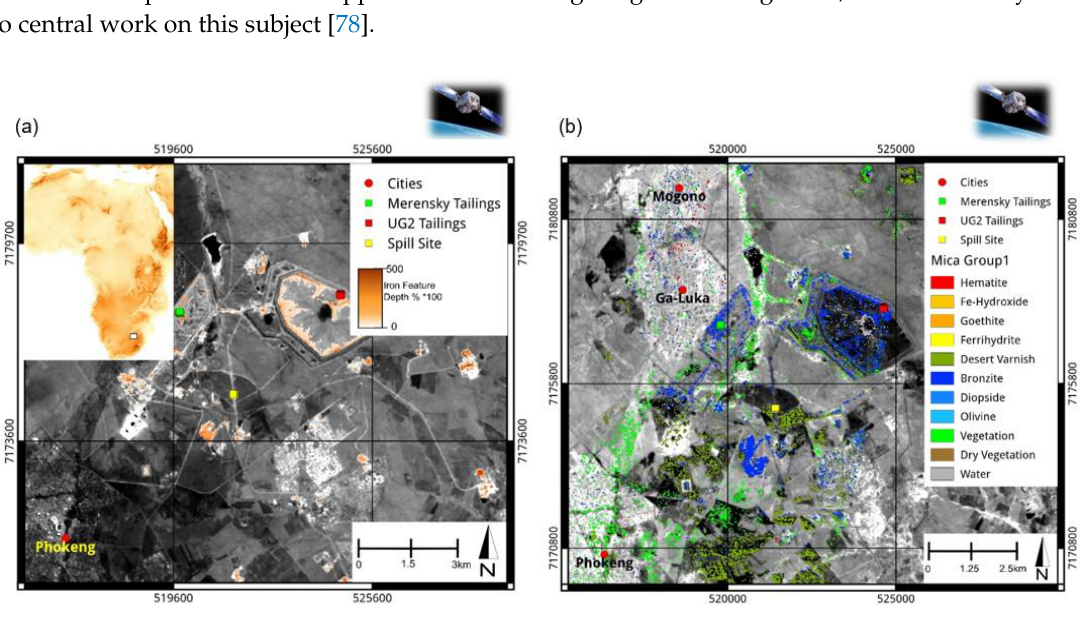
Figure 4. Geological classification: ( a ) Expert system result showing mineral and material abundance in the Platinum mining area near Rustenburg (USGS MICA) from EO-1 Hyperion data; expert system result overlaid with Landsat-8 OLI near-infrared channel. ( b ) Iron feature depth result calculated from Landsat-8 OLI data in the Platinum mining area near Rustenburg (USGS MICA). Expert system result overlaid with Landsat-8 OLI short-wave infrared channel. Inset map of the topography of Africa from ETOPO-1 data (data provided with the courtesy of NOAA). White rectangle outlines the areas that are most affected by mining activity in South Africa. (from Mielke et al. [98]).